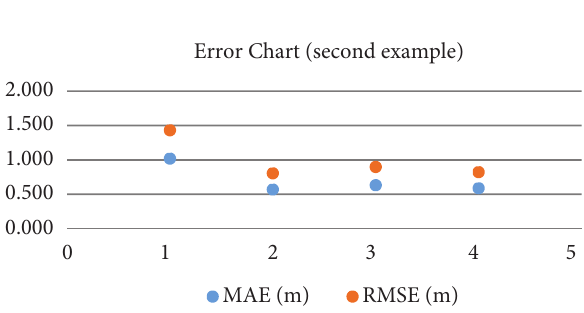
Table 2. Results on MAE and RMSE analysis